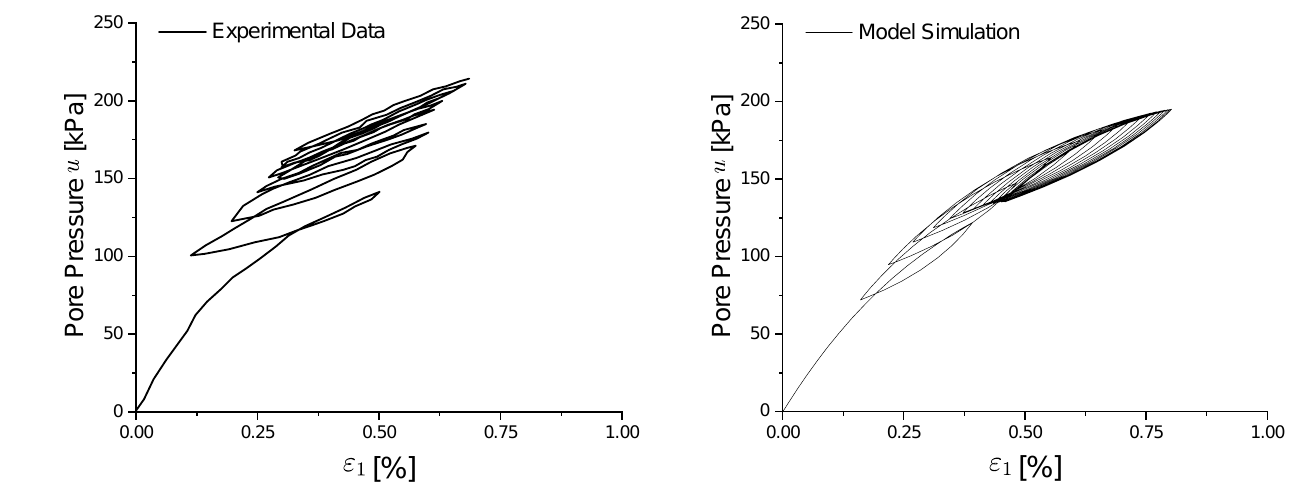
Figure 11. Experimental and numerical comparison of Newfield clay pore pressure–strain evolution under cyclic loading.